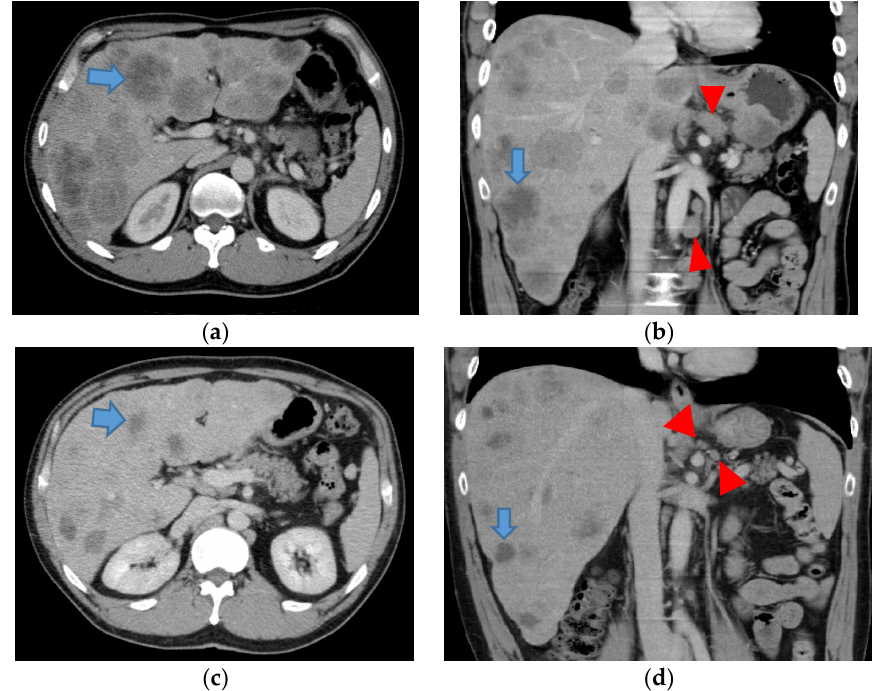
Figure 1. CT scan showed multiple liver tumors and swellings of lymph nodes before the start of chemo-immunotherapy with trastuzumab ( a , b ). Liver tumors ( blue arrows ) and lymph nodes (red arrow heads) remarkably decreased in size after four cycles of treatment ( c , d ).